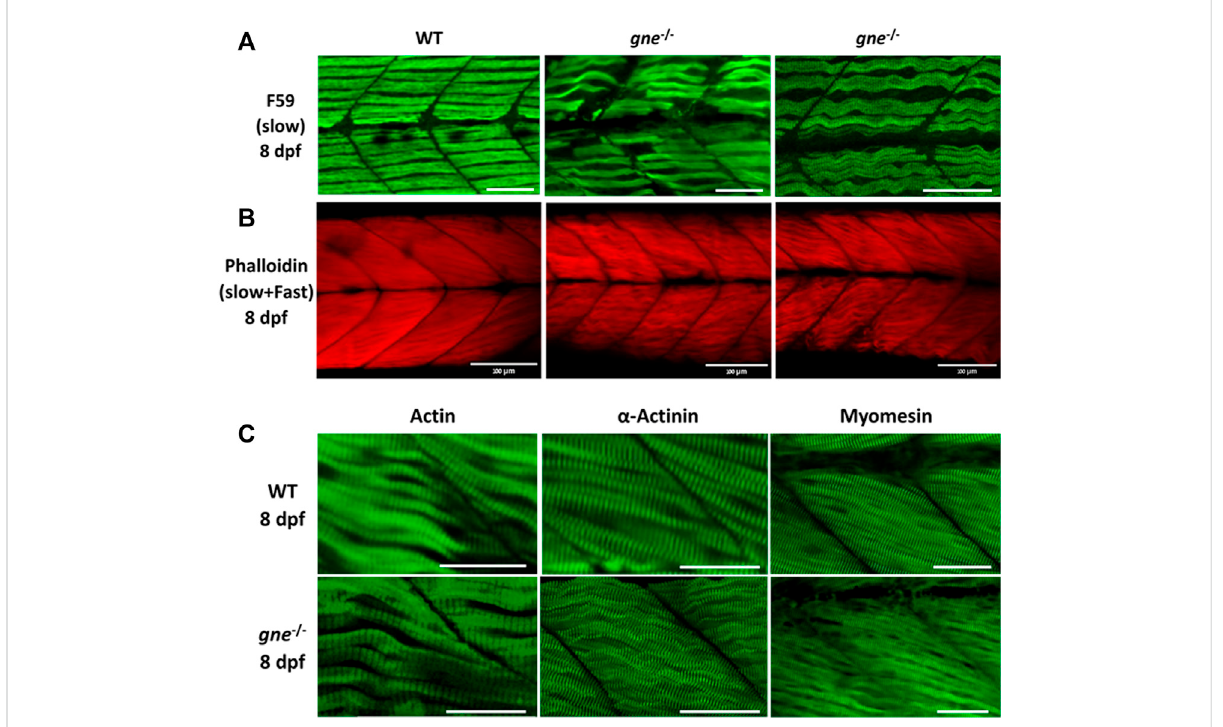
FIGURE 6 gne KOlarvaepresentdisorganizedslowandfastmuscle fi bersat8dpf. (A) ConfocalimagingofF-actinstained gne KOmuscleat8dpf. gne KO larvae show an abnormal Phalloidin staining pattern relative to the WT control at 8 dpf. Scale bar = 100 µm. (B) Confocal imaging of whole-mount immunostained larvae at 8 dpf by gne genotype. Zebra fi sh gne KO larvae exhibit impaired organization of the slow muscle fi bers, stained with F59antibody.Scalebar=50 µm. (C) Confocalimagingofwhole-mountimmunostainedlarvaeat8dpfby gne genotype. gne KOlarvaeexhibita wavy pattern of the fast muscle fi bers, and correct localization of Actin, Actinin, and Myomesin. Scale bar = 50